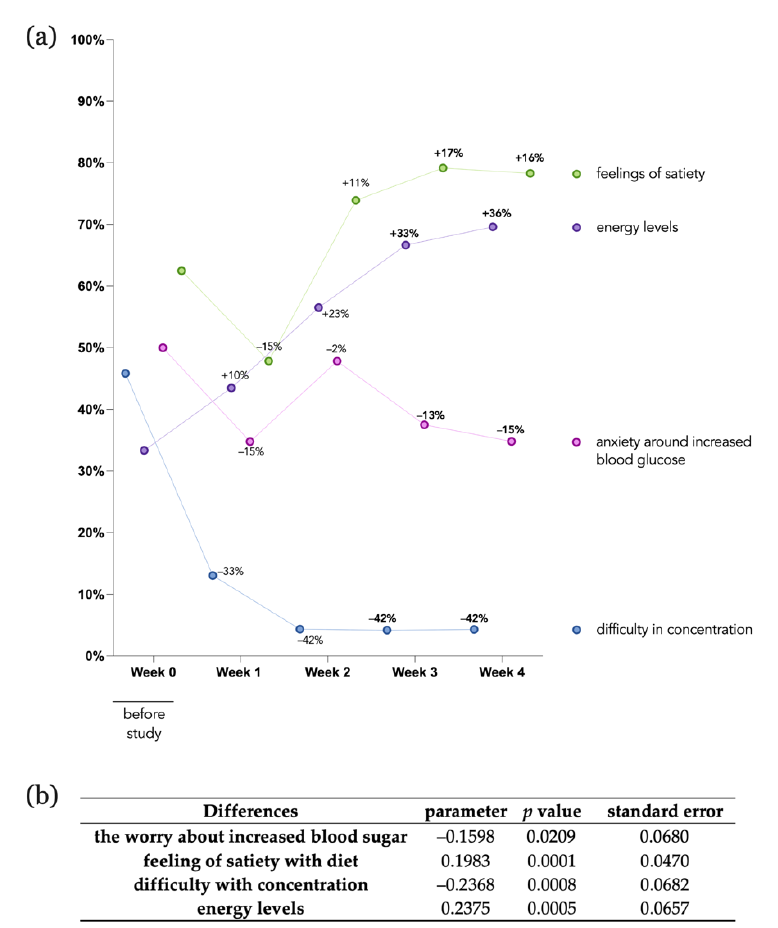
Figure 3. Participant-reported outcome measures. Self-reported energy levels, anxiety around increased blood glucose, feelings of satiety, and difficulty in concentration were measured weekly over the course of the programme. ( a ) Percentage (%) of participants agreeing or strongly agreeing with the statement are shown. Percentages (%) depicted directly in the line-dot graph describe the relative weekly difference compared to baseline questionnaire. ( b ) Panel OLS fixed-effect model regression analysis outcomes including estimated parameter, p -values, and standard error for each question is shown. Time was used as the independent variable (Y) and the question as the dependent variable (X) for the within-individual effects, and the standard error was clustered for one person. Data were tested for normal distribution.